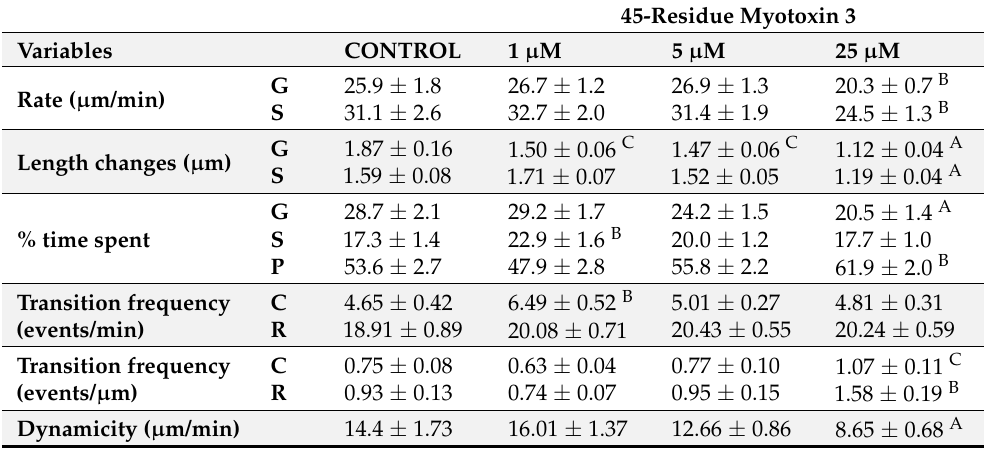
Table 1. Effects of myotoxin-3 on the parameters of microtubule dynamic instability in MCF7